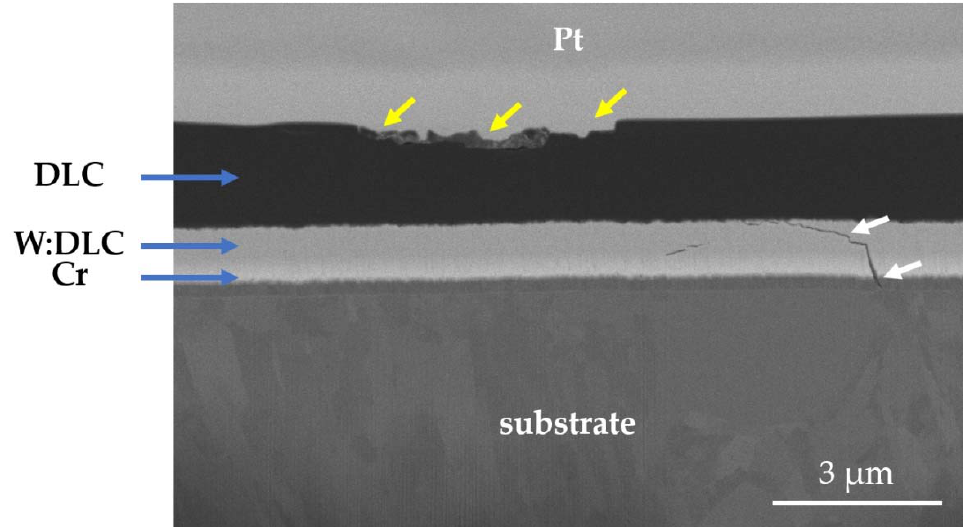
Figure 15. Backscattered electron SEM micrograph of the cross-section of a wear track, obtained on DLC-coated 440B stainless steel. The cross-section was obtained with the use of FIB.